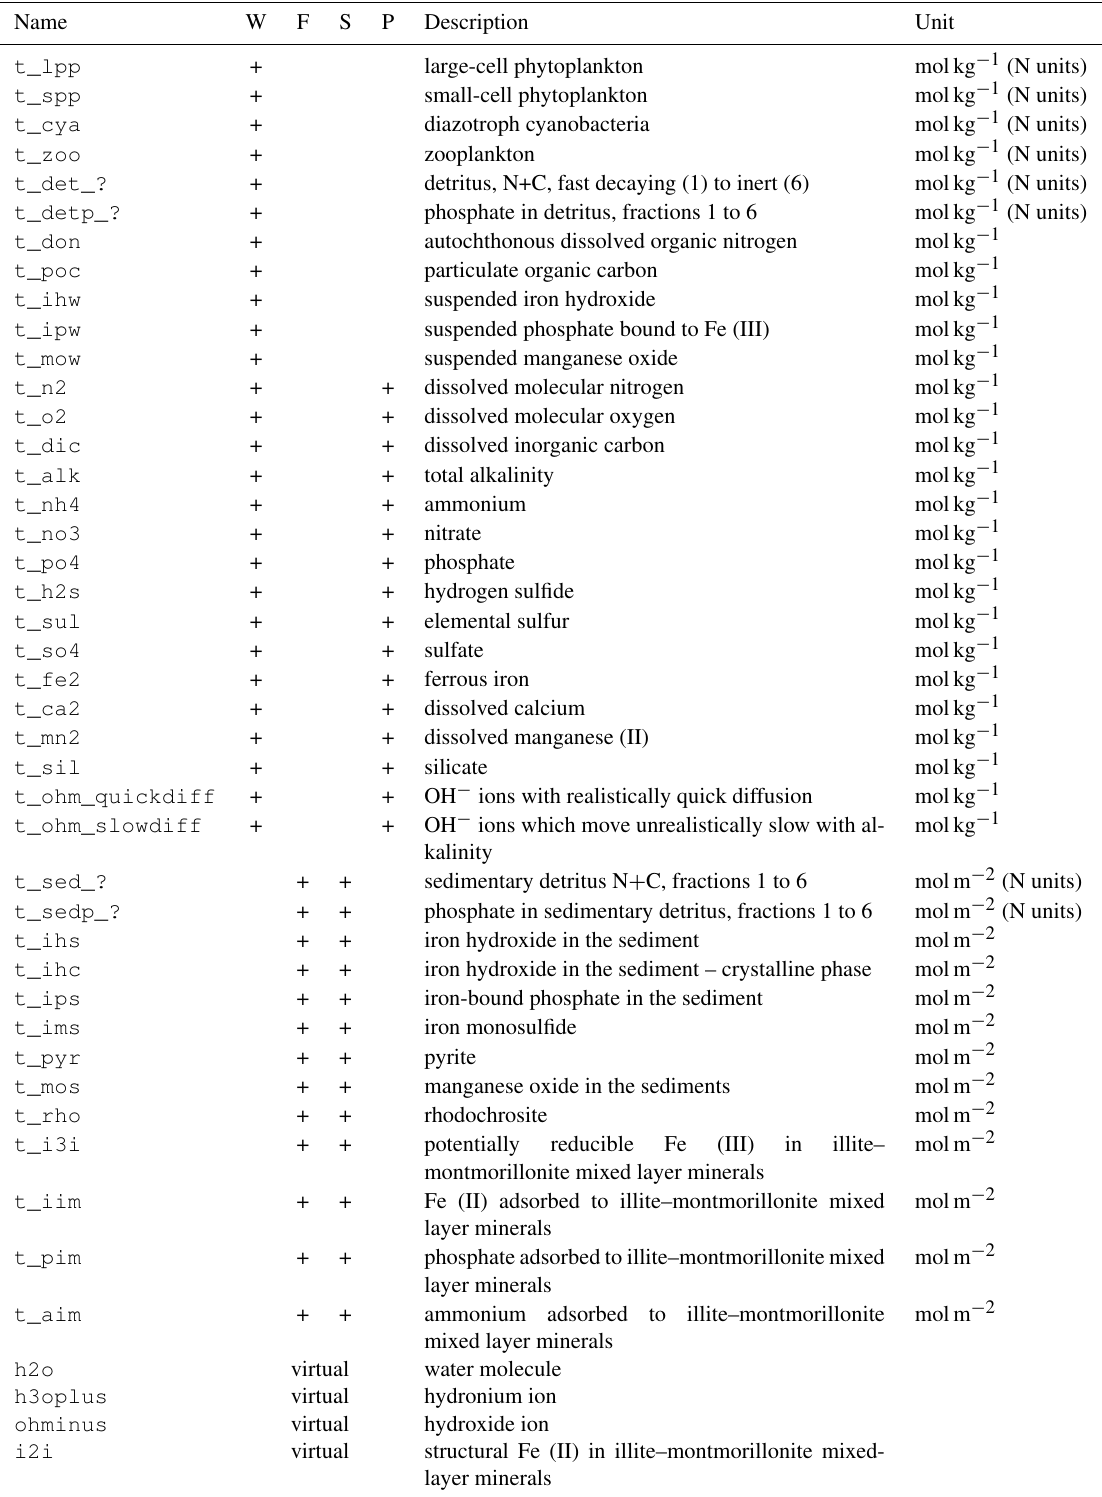
Table 1. Tracers used in the ERGOM SED v1.0